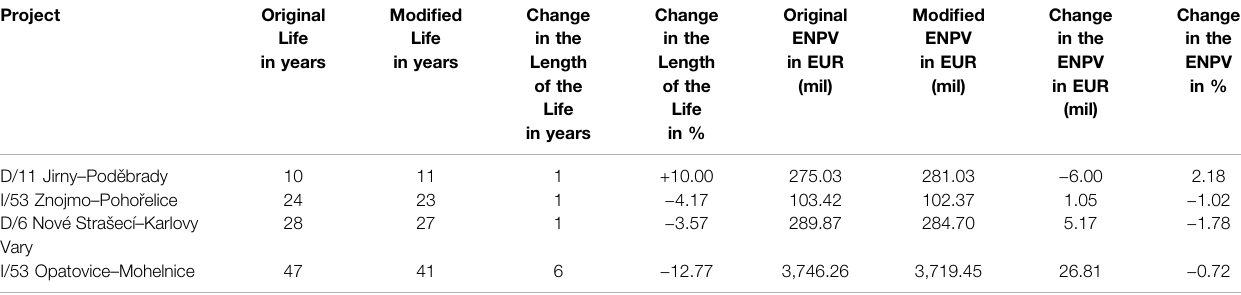
TABLE 3 | Impact of the change in the project service life length on project effectiveness.